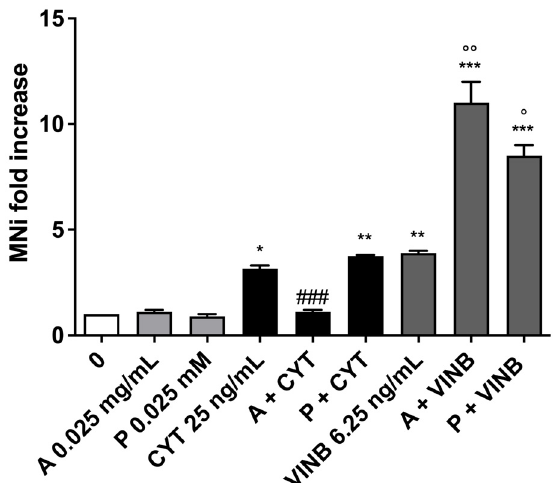
Figure 11. MNi fold increase on TK6 cells after 26 h treatments with A. leucotrichus (A) at the indicated concentrations in the presence or absence of CYT (clastogen) or VINB (aneugen) compared to the negative control (0) and the relative positive controls. * p < 0.05; ** p < 0.01; *** p < 0.001 vs. 0; ° p < 0.05 vs. VINB; °° p < 0.01 vs. VINB; ### p < 0.001 vs. CYT.